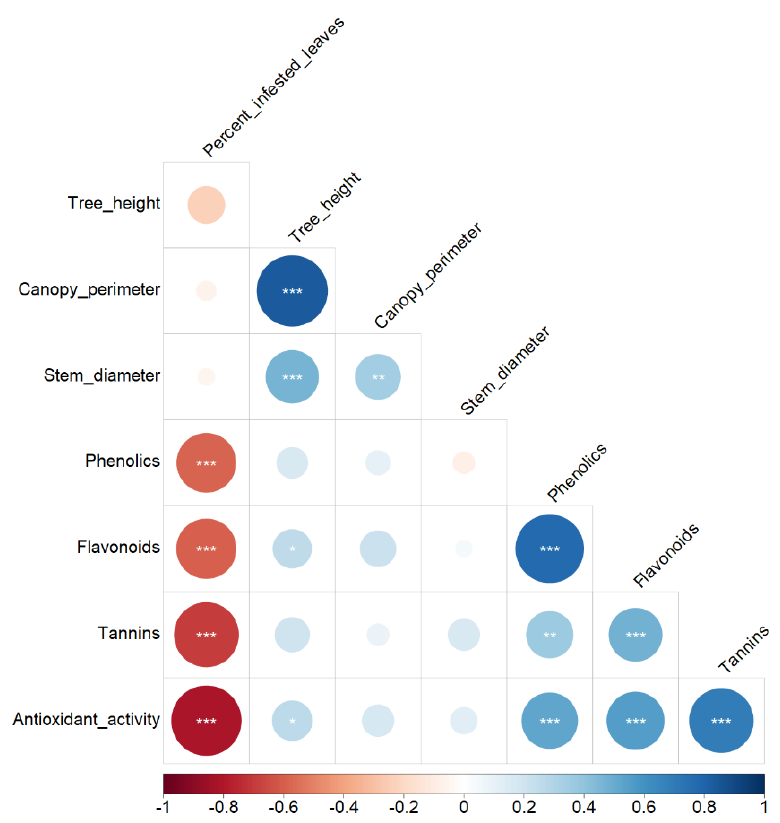
Figure 3. Correlogram representing the Pearson correlation coefficient matrix between percent of infested leaves, vegetative traits, and leaf composition. Asterisks indicate the significance of the Pearson correlation coefficient (*, **, *** correspond to p ≤ 0.05, 0.01 and 0.001, respectively). Colors indicate different values of the correlation coefficient according to the scale bar reported at the bottom. The size of the circle is proportional to the correlation